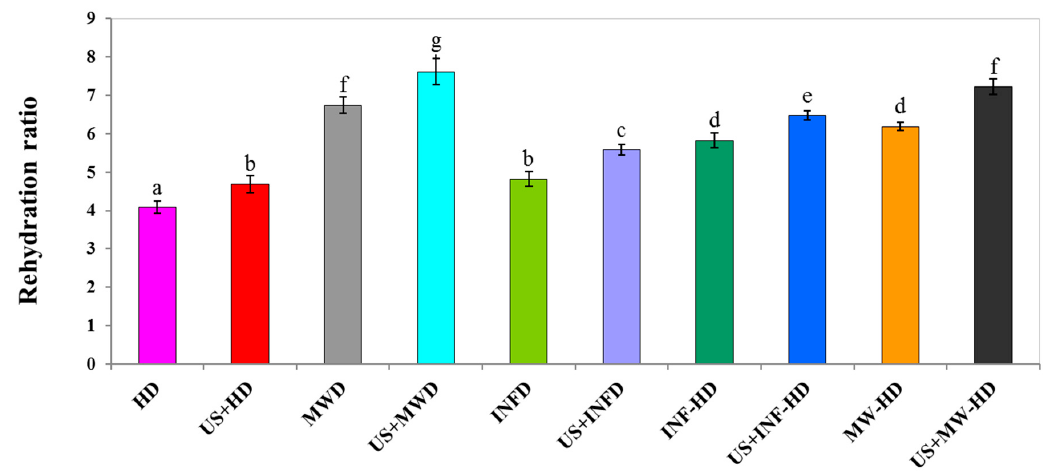
Figure 5. The effect of the different drying methods on the rehydration ratio of carrot. Figure 5. The e ff ect of the di ff erent drying methods on the rehydration ratio of